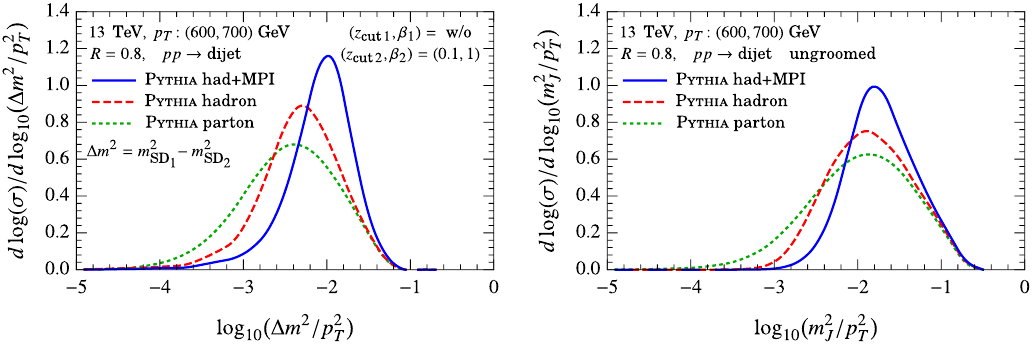
Figure 17 . Collinear Drop with ( z cut1 ; (cid:12) 1 ) turned o(cid:11) and ( z cut2 ; (cid:12) 2 ) = (0 : 1 ; 1) as well as ungroomed jet mass distributions from Pythia simulations. Results at parton and hadron (with and without multi-parton interactions) levels are